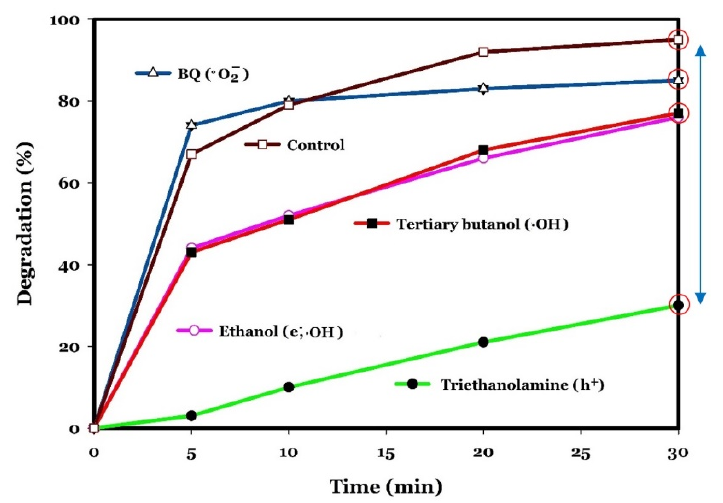
Figure 7. Decreased photocatalytic degradation of CIP (5 mg/L) using ZnO/Bentonite (0.5 g/L), as a result of the addition of different scavenging agents.